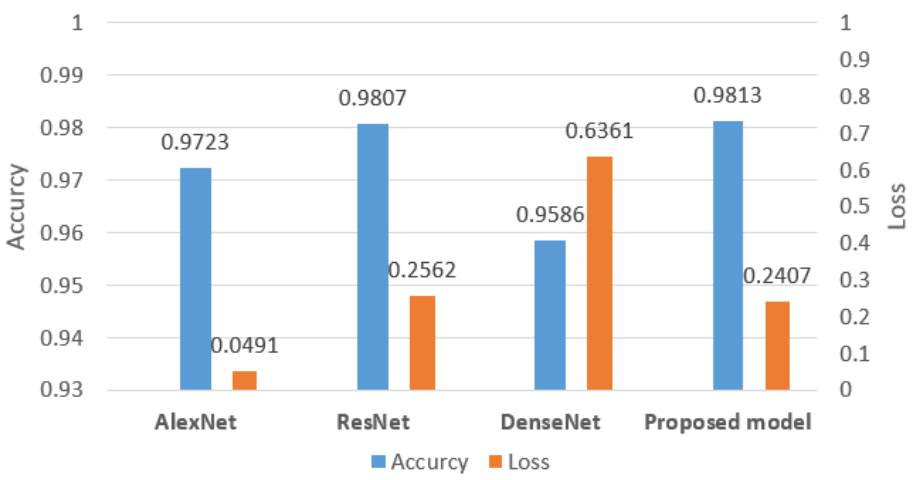
Figure 11. Performance Comparison of Neural Network Models using Caltech 101 Data.